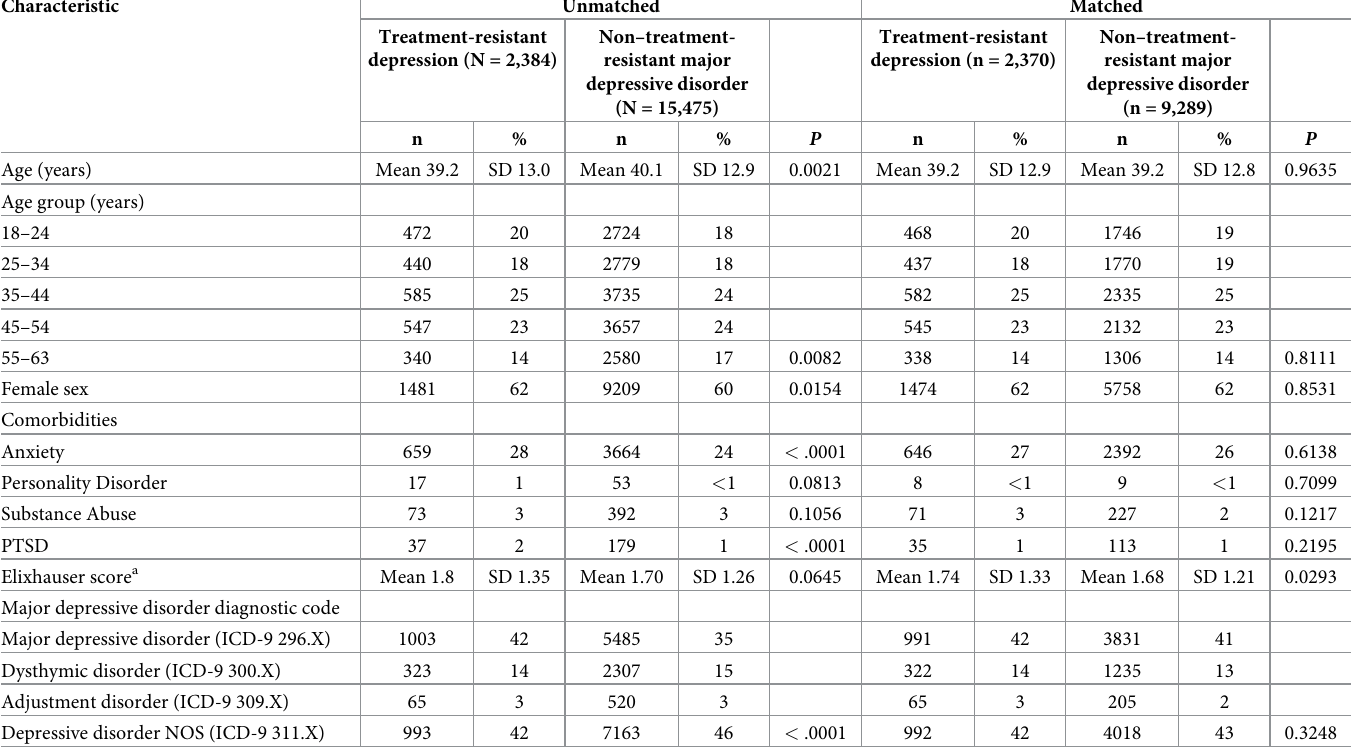
Table 1. Demographic and clinical characteristics of patients with treatment-resistant depression and non–treatment-resistant depression before and after the pro- pensity score matching. Characteristic